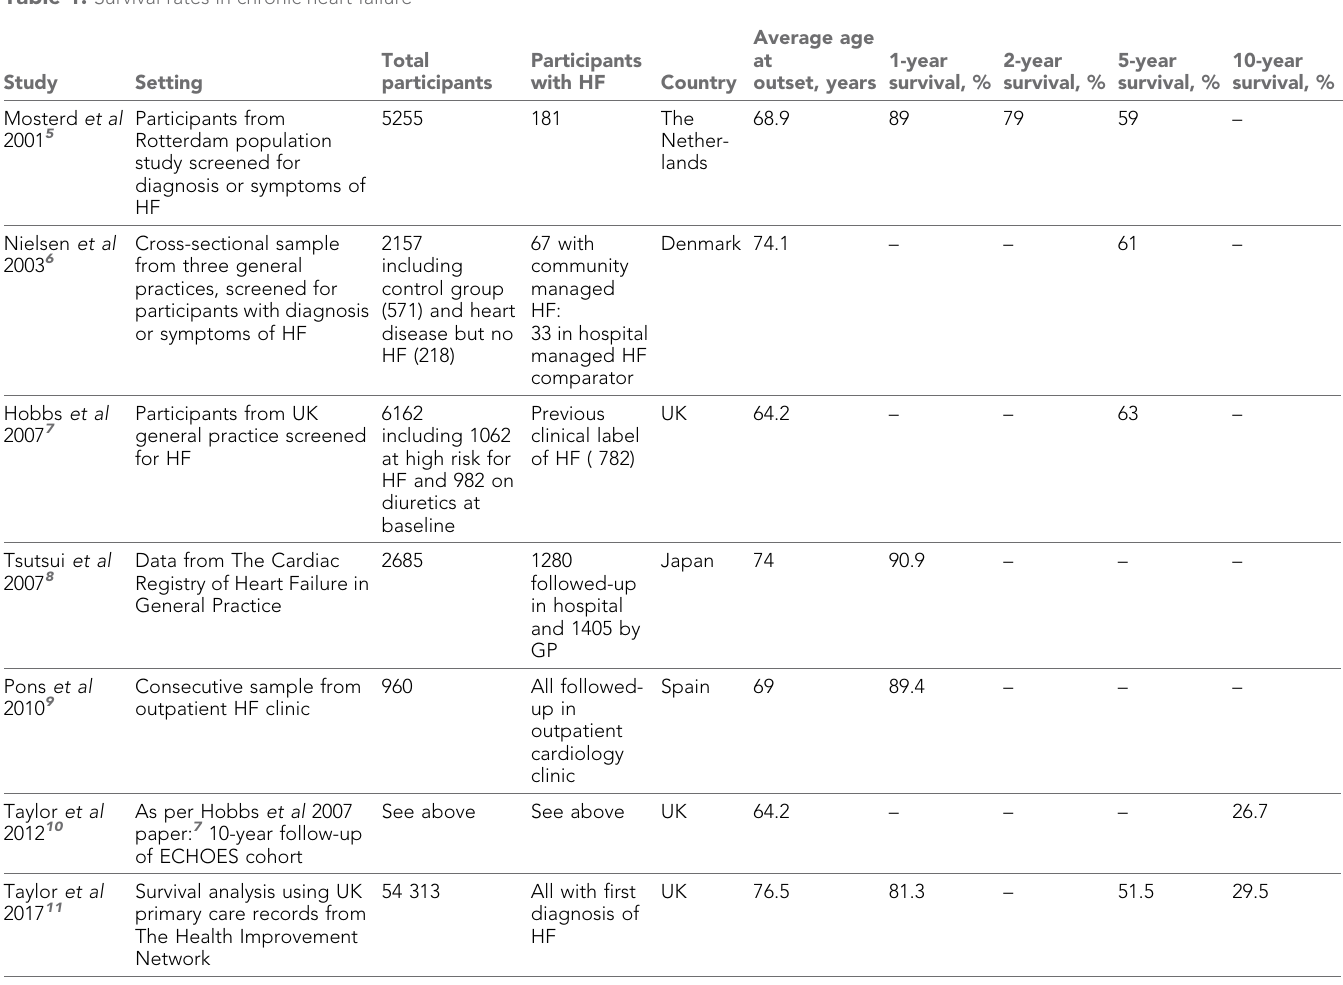
Table 1. Survival rates in chronic heart